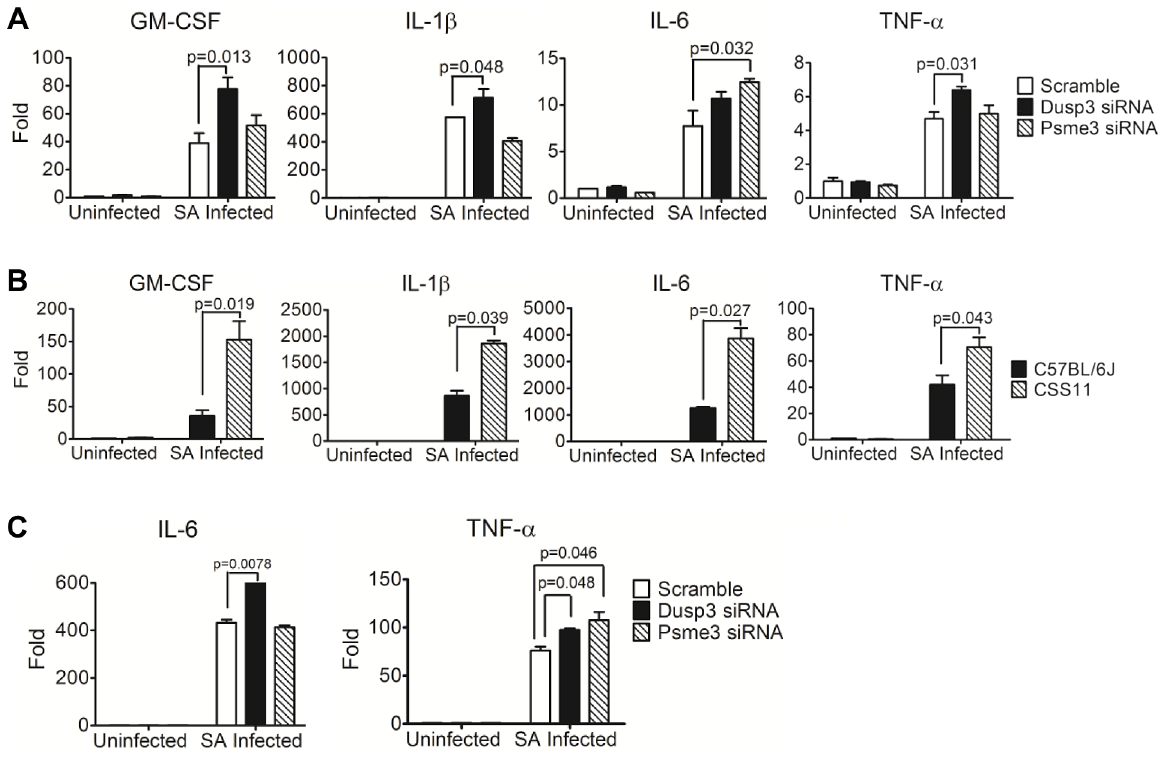
Figure 6. Quantitative-PCR confirmed elevation of cytokine production in macrophages transfected by Dusp3 and Psme3 siRNA or BMDMs from CSS11(GM-CSF, IL-1 b , IL-6, and TNF- a ). ( A ) Down-regulation of Dusp3 and Psme3 by siRNA led to increased cytokine RNA expression upon S. aureus challenge in RAW264.7 macrophages. At three hours post-infection total RNA was extracted followed by reverse- transcription PCR and SYBR-Green qPCR. The expression of all genes were normalized to 18s rRNA. The expression level of GM-CSF, IL-1 b , IL-6, and TNF- a was higher in Dusp3 knockdown RAW cells, and the level of GM-CSF and IL-6 was higher in Psme3 knockdown RAW cells. p-value smaller than 0.05 was considered significant. ( B ) BMDMs cytokine RNA production in CSS11 mice was significantly higher than in C57BL/6J upon S. aureus infection. 2 6 10 6 BMDMs were seeded to single wells in a 6-well plate the day before infection. At three hours post-infection, RNA was extracted using RNeasy followed by RT-PCR and qPCR. The expression levels of GM-CSF, IL-1 b , IL-6, and TNF- a were significantly higher in BMDMs from CSS11 mice. The expression of all genes were normalized to 18s rRNA. p-value smaller than 0.05 was considered significant. ( C ) Down-regulation of Dusp3 and Psme3 by siRNA led to increased cytokine RNA expression upon S. aureus challenge in BMDMs of C57BL/6J. The expression level of IL-6 was higher in Dusp3 siRNA transfected BMDMs, and the expression of TNF- a was higher in both Dusp3 and Psme3 siRNA transfected BMDMs.